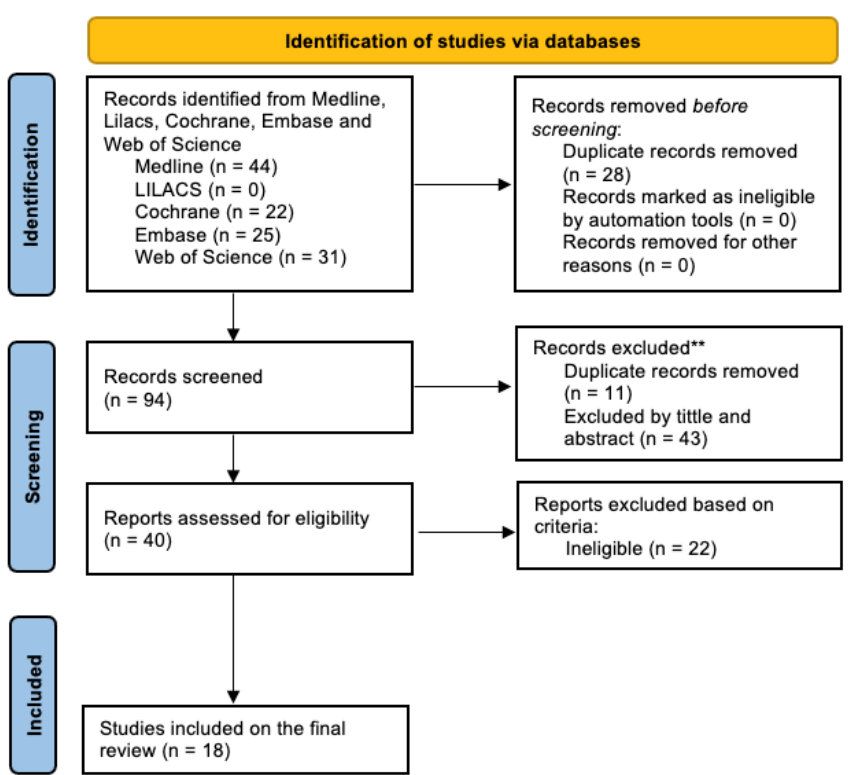
Figure 1. Flowchart of the included studies.